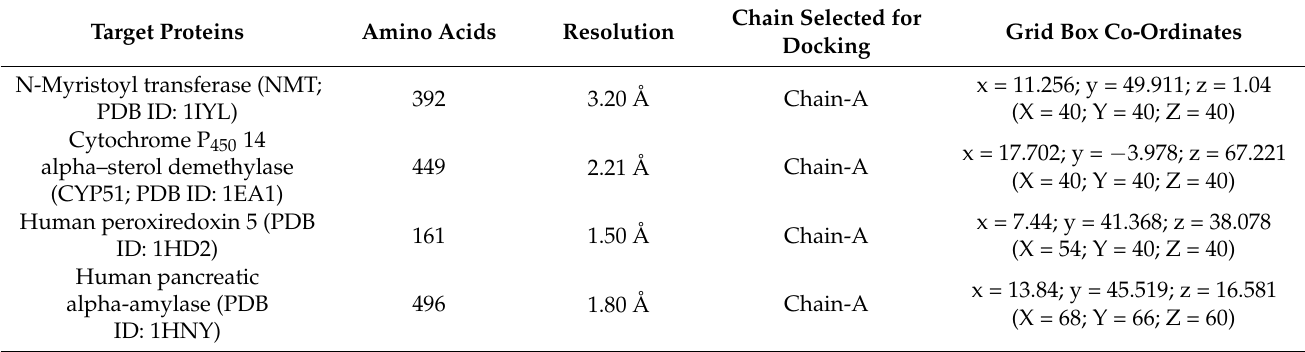
Table 8. Details of target proteins and grid box coordinates for